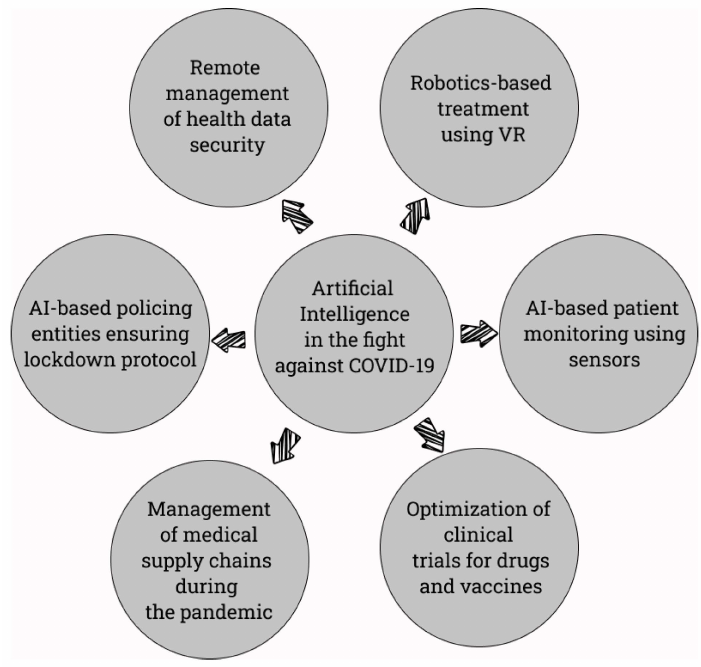
Figure 8. Uses of AI in the fight against COVID-19